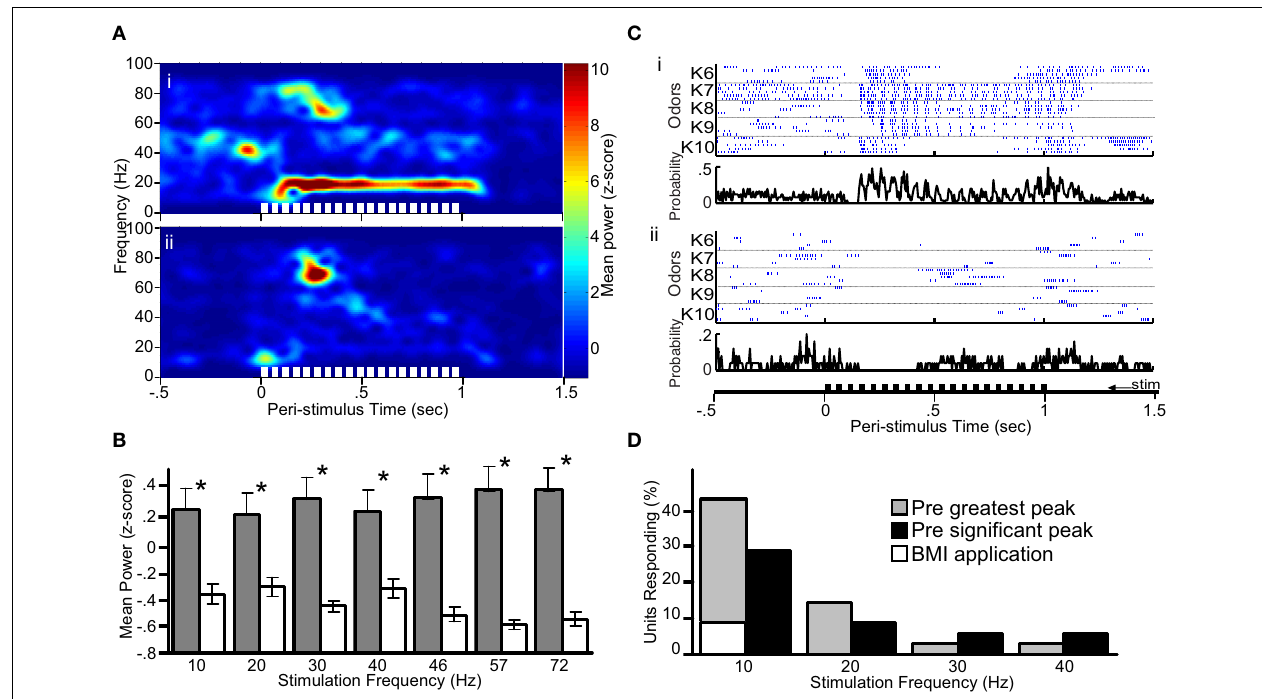
FIGURE 5 | The specifi c GABA antagonist BMI affects LFP and single differences in power for comparisons of pre- versus post-BMI application A unit responses to pulsed stimuli. (A) Spectrogram of LFP before (i) and ( t -test, p < 0.05). Note values for pre-BMI are signifi cantly larger than during ( ii ) BMI bath application (200 µM) in response to a 1 s 20 Hz pulse train post-BMI at all frequencies. (C) Raster and histogram for a single unit in with 1-hexanol. Average values are based on 10 (i) and 5 ( ii ) repetitions from response to fi ve 1-s long 20-Hz pulse trains using 6–10 carbon ketones before the same animal. Color bar on right and x -axis indicates values for both (i) and during ( ii ) BMI bath application. Histogram binned at 0.005 s. (D) graphs. The strong power band around 20 Hz (i) is completely abolished by Percentage of single units responding to pulsed odor presentations before BMI ( ii ). (B) Mean integrated LFP power pre- (dark grey bars) and post- (white and after BMI superfusion (35 total units, 3 animals) based on the statistical bars) BMI application. Stimulation frequencies are indicated on the x -axis. (black) and highest peak criterion (grey). For both conditions, white bars Results based on z -score normalization performed within each stimulation indicate the respective percentage of units that continued to pulse track frequency and each animal. Asterisks indicate statistically signifi cant during BMI